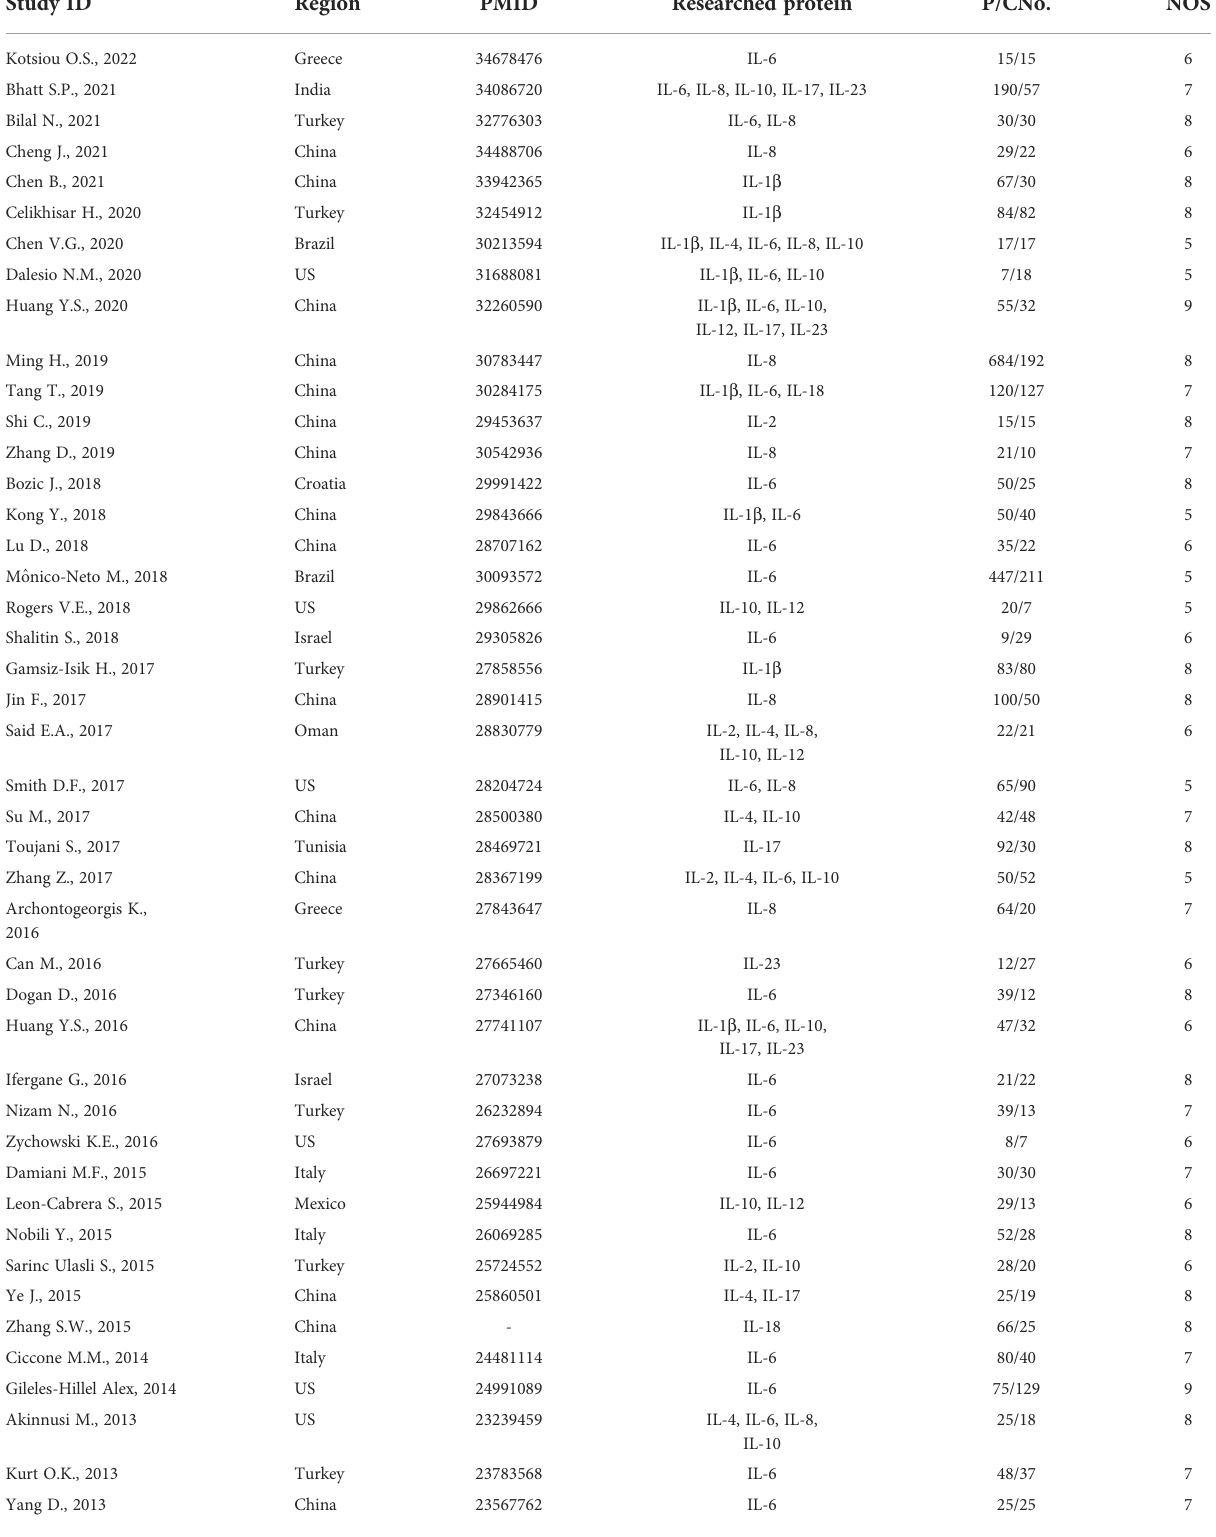
TABLE 1 Characteristics of the included studies about interleukin levels in patients with OSA and